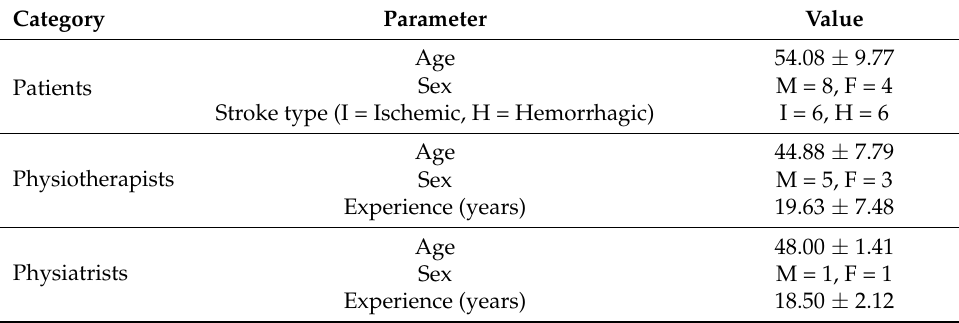
Table 3. Study population